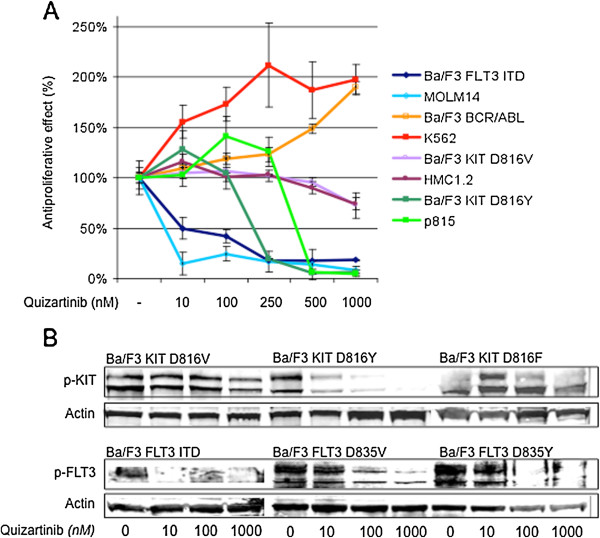
Cellular effects of quizartinib are tyrosine kinase-mediated (A) Quizartinib displays distinct antiproliferative effects of genetically altered Ba/F3 cells in dependence of the tyrosine kinase isoform transfected. The sensitivity of inhibition of proliferation is thereby similar to the sensitivity achieved in natural leukemia cell lines harboring a similar mutation. Estimated IC50s are provided in Table 3 along with IC50s for the proapoptotic effects in the same cellular context. (B) The observed cellular effects are directly linked to the potency of inhibition of phosphorylation of mutant-KIT and FLT3 isoforms. Whole cell lysates of Ba/F3 cells transfected with different human mutant-KIT or -FLT3 isoforms were immunoblotted using a pan-phosphotyrosine antibody or a total-KIT or -FLT3 antibody. Pretreatment of cells with quizartinib revealed isoform-specific inhibition of phosphorylation. Notably, inhibition of phosphorylation of the D816V mutation was significantly reduced compared to the D816Y and D816F isoforms.